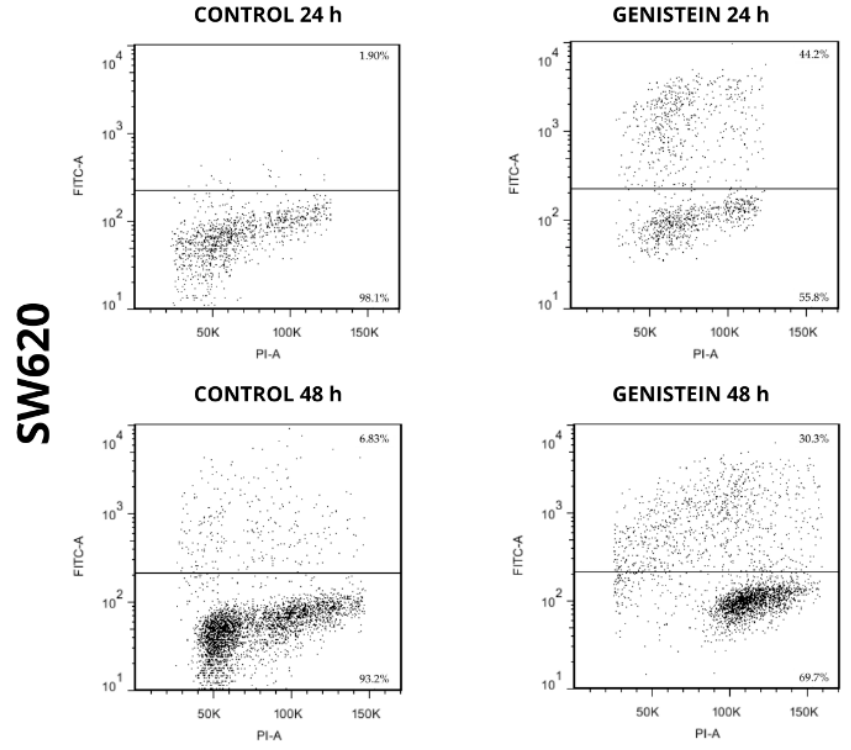
Figure 8. Genistein induces cell death in SW620 cell line. Dot plot of PI/FITC in SW620 cell line after treatment with genistein in two periods of time (24 h and 48 h).